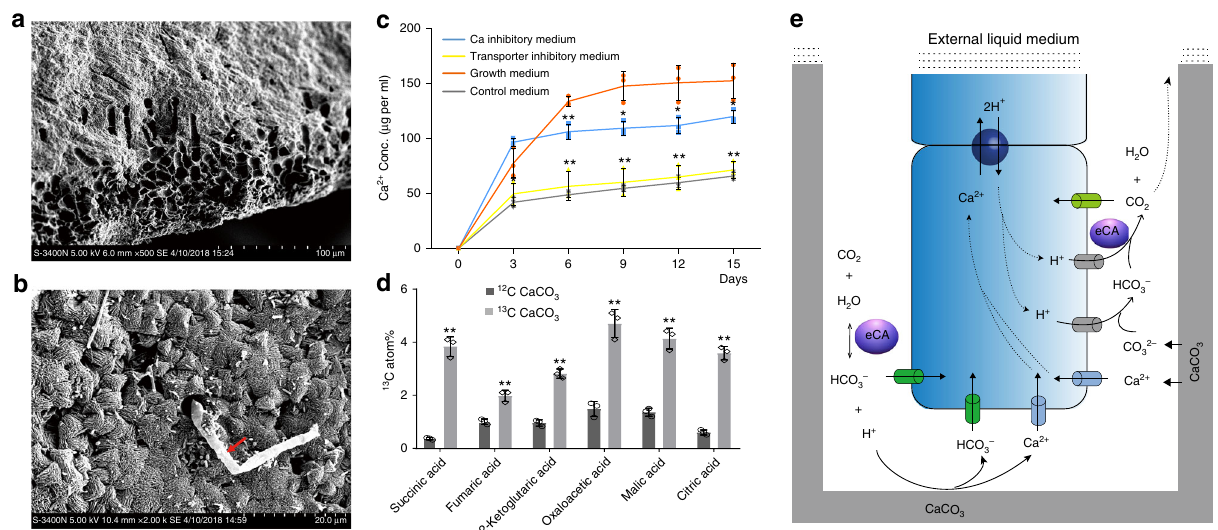
Fig. 4 The digestion of shell CaCO 3 by the conchocelis and the function of extracellular carbonic anhydrase. a Boreholes in the calcareous matrix of mollusk shells occupied by Pyropia conchocelis. b Microscopic image of conchocelis living in mollusk shells. The red arrow indicates the conchocelis in the borehole in shell calcareous matrix. Microscopic observation in a and b were repeated independently on multiple shell conchocelis ( n > 10) showing similar structure. c The variation of Ca 2 + release from conchocelis-dwelling shell w/o inhibitors of carbonic anhydrase or P-type transporter. Triplets were done for each condition. Ca 2 + concentrations in control medium, growth medium, CA inhibitory medium, and transporter inhibitory medium were plotted in gray, red, blue, and yellow, respectively. Time refers to the duration (in days) since the addition of inhibitors. The following comparisons were done: growth vs control, growth vs CA inhibitory or P-type ATPase inhibitory medium. Vertical bars represent the SD ( n = 3 biological independent samples). P value in each comparison was calculated by two-sided independent t test in SPSS. Variations with P < 0.05 were considered to be signi fi cant as indicated by asterisks. One asterisk: 0.01 < P < 0.05; two asterisks: P < 0.01. d The abundance of 13 C isotope in organic acids of TCA cycle in conchocelis co-cultured with 12 C-CaCO 3 or 13 C-CaCO 3 . Columns and vertical bars represent the mean and SD, respectively ( n = 3 biological independent samples). Statistical analysis was done by two-sided independent t test in SPSS. Two asterisks indicated P < 0.01. e A working model for the dissolution of shell CaCO 3 and utilization of generated carbon fl ux in conchocelis. Only the apical conchocelis cell and part of its adjacent cell are shown in this model. Extracellular CA was represented by purple ovens. Transporters or channels of bicarbonate, CO 2 , Ca 2 + , and protons are indicated by green, light green, blue, and gray cylinders, respectively, across the cell membrane. The P-type calcium transporter is indicated by the dark blue circle. Source data underlying Fig. 4c, d are provided as a Source data fi